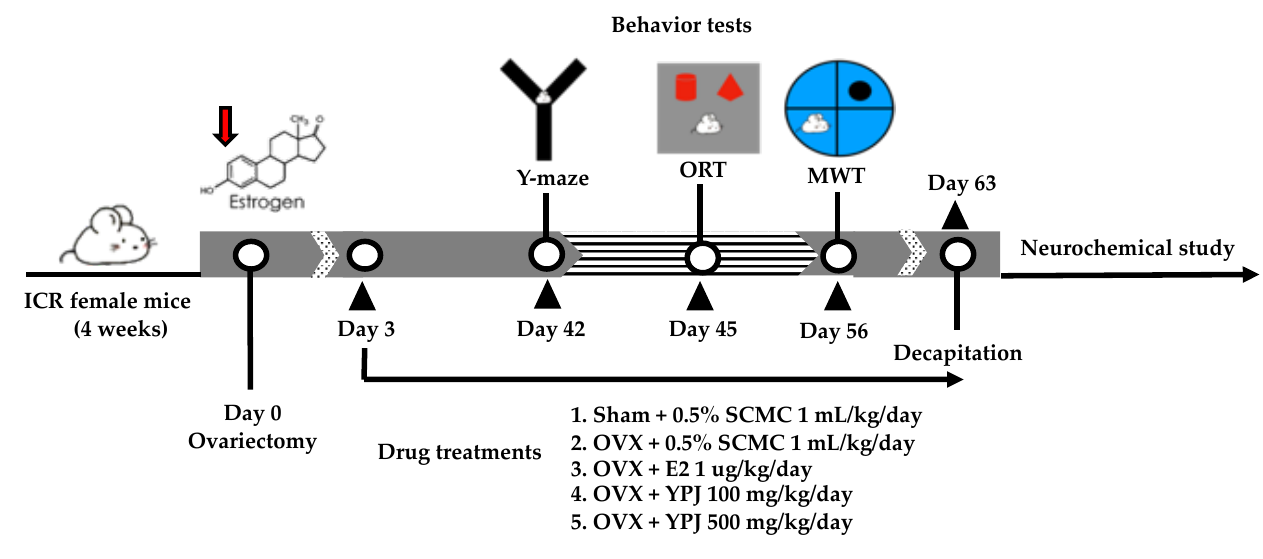
Figure 8. A schematic drawing of the experimental protocol.